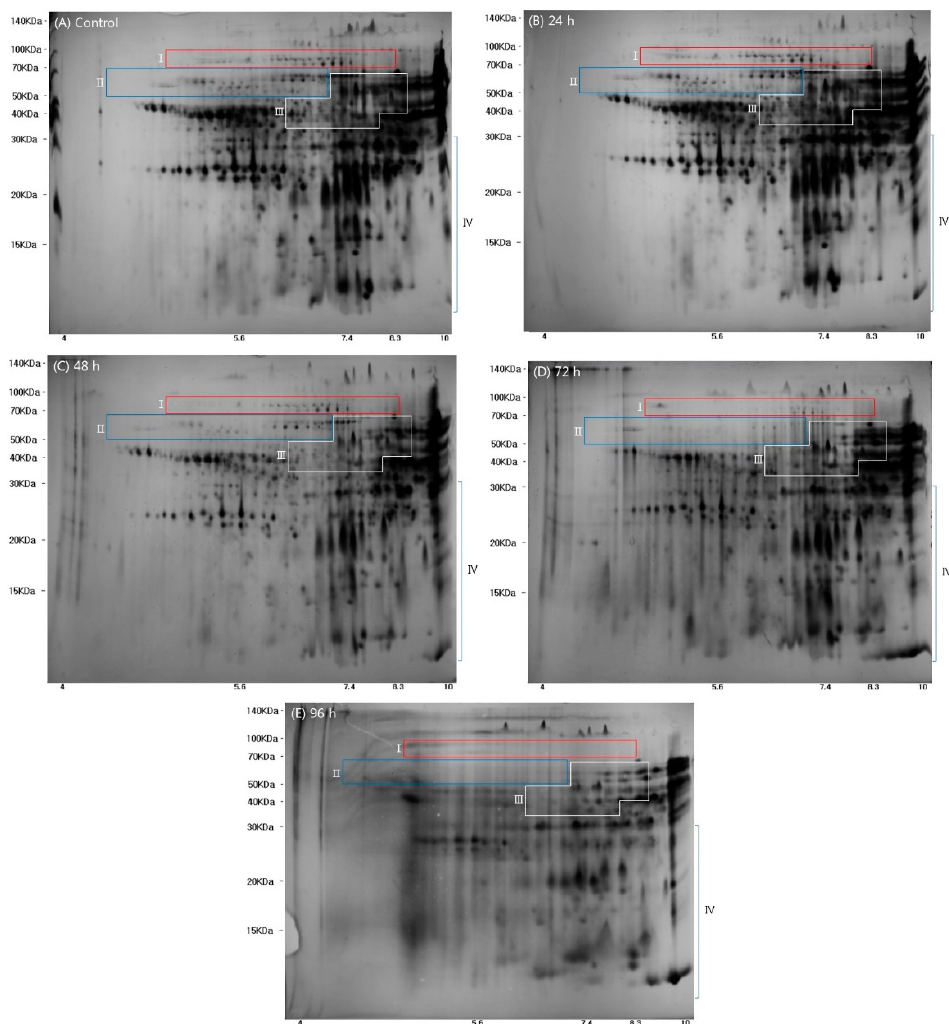
Figure 2. Images of proteins separated after two dimensional gel electrophoresis of ungerminated control wheat grains and wheat grain samples germinated for various times (24, 48, 72, and 96 h) control. (Regions I, II, III, and IV represent (I) high molecular weight glutenin subunit, (II) ω -gliadins, (III) α / β , and γ gliadins and the low molecular weight glutenin subunit; and (IV) nonstorage proteins).